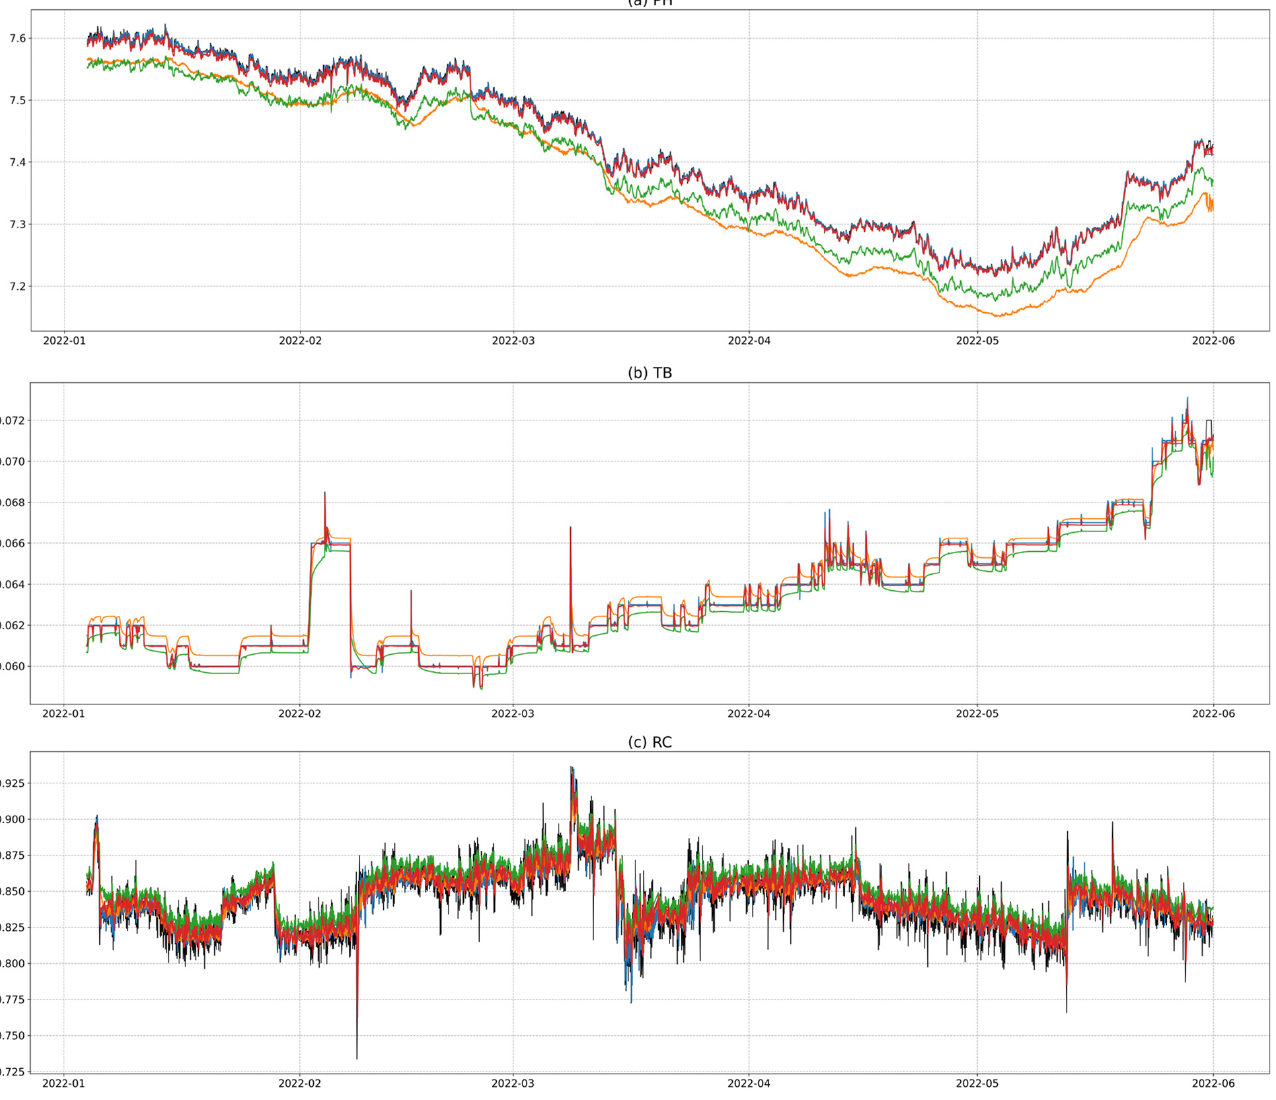
Figure 15. Comparison of actual and predicted ( a ) PH, ( b ) TB, and ( c ) RC values for ARIMA, LSTM, GRU, and SCINet models.